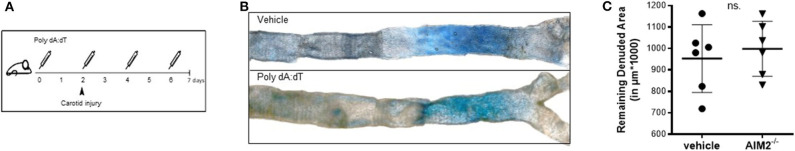
Acute vascular injury in AIM2−/− mice. (A) AIM2−/− mice were subjected to an electric denudation of the left common carotid artery and the reendothelialization was quantified 5 days after surgery. 50 μg poly dA:dT or vehicle (PBS), each n = 6, was injected i.v. every 48 h starting 2 days prior to the carotid injury. (B) Representative images of carotid arteries are shown with blue area indicating the remaining denuded area. (C) Treatment with poly dA:dT did not impair vascular reendothelialization in AIM2−/− mice compared to vehicle controls, each n = 6. Remaining denuded area is shown. Kolmogorov-Smirnov test and D'Agostino-Pearson omnibus test were used to test normality of data distribution. Normally distributed data was tested using the unpaired t-test, non-normally distributed data using the Mann-Whitney U-test. Mean values ± SD are shown, p < 0.05 were considered as significant; ns, non-significant.